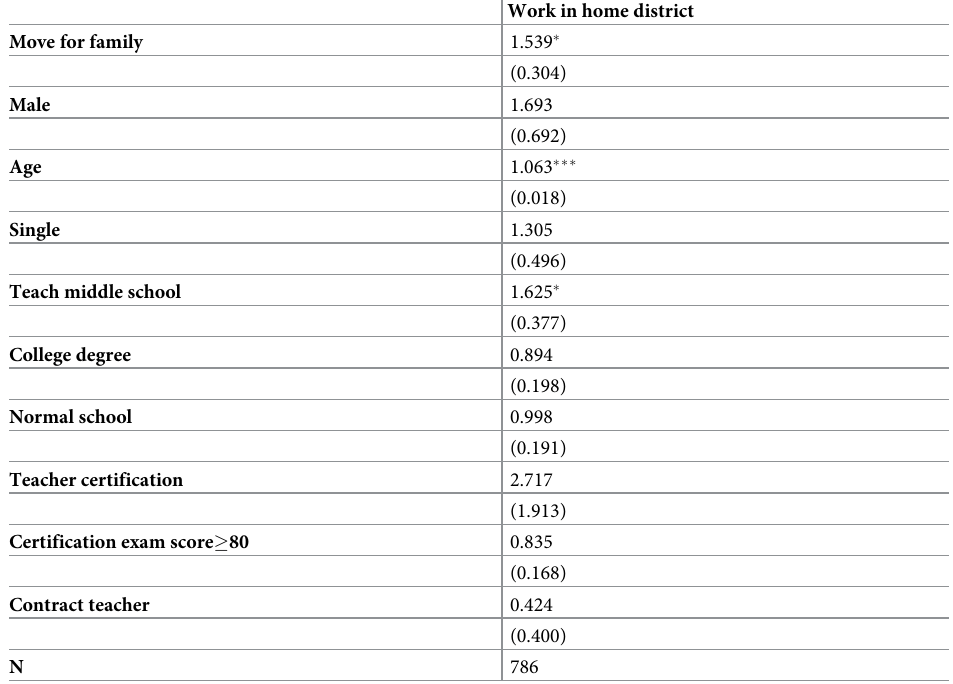
Table 6. Estimation results of the relationship between “move for family” and current work